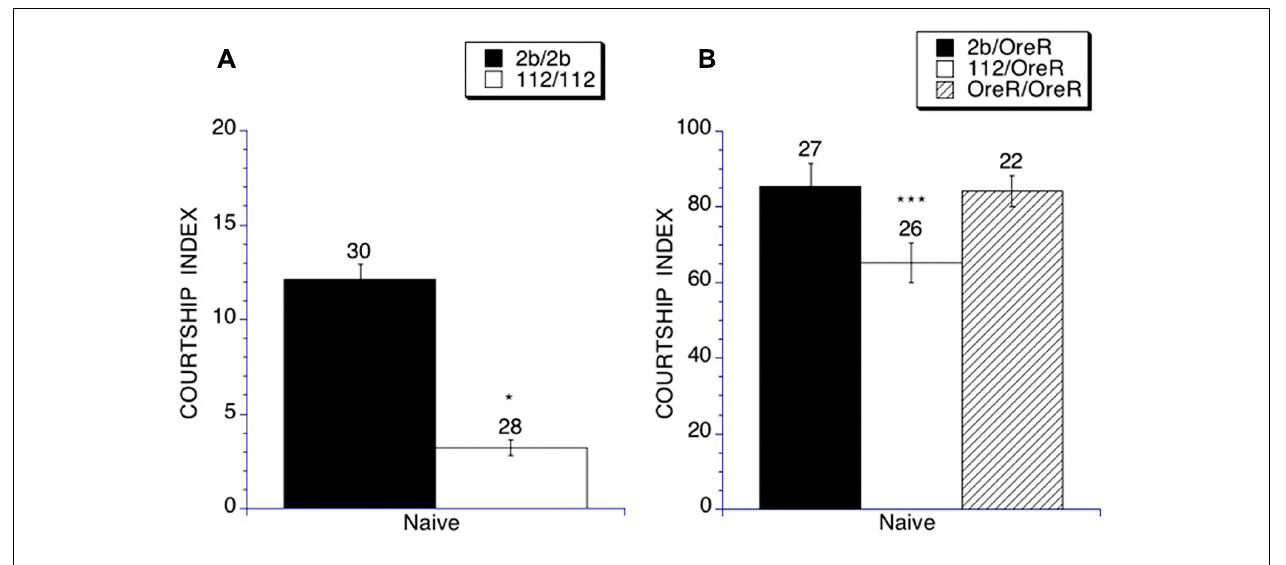
FIGURE 1 | Social interaction (Naïve courtship) is impaired in homozygous and heterozygous DmGluRA 112 mutant flies. Naïve courtship of DmGluRA , DmGluRA 112 homozygous mutant flies, control DmGluRA 2b precise excision homozygous flies, DmGluRA 112 heterozygous mutant flies, control DmGluRA 2b precise excision heterozygous flies and control OreR background flies were used. Panel (A) Filled black bars indicate control homozygous males ( DmGluRA 2b precise excision, 2b/2b) and open bars indicate DmGluRA 112 homozygous mutant